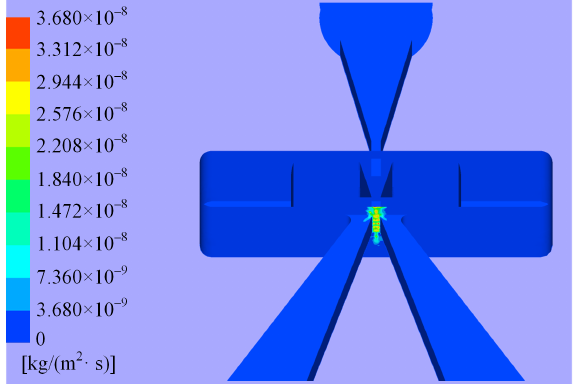
Figure 6. Overall erosion rate distribution in deflector jet